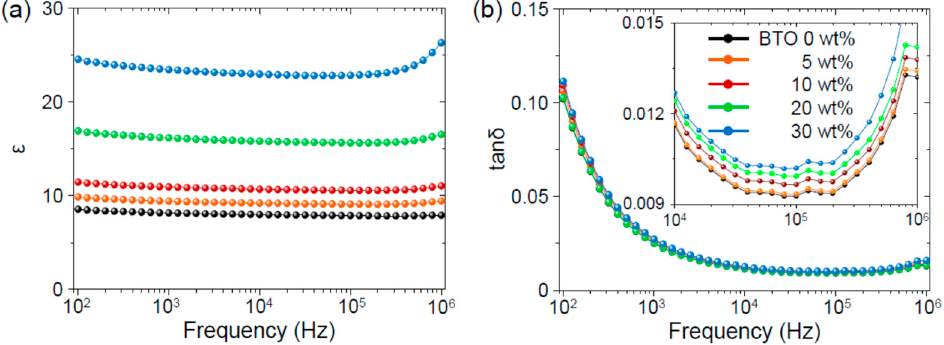
Figure 3. ( a ) Dielectric constants and ( b ) loss tangents of the PVDF–BTO composites. Magnified dielectric loss tangents are shown in the inset of ( b ).